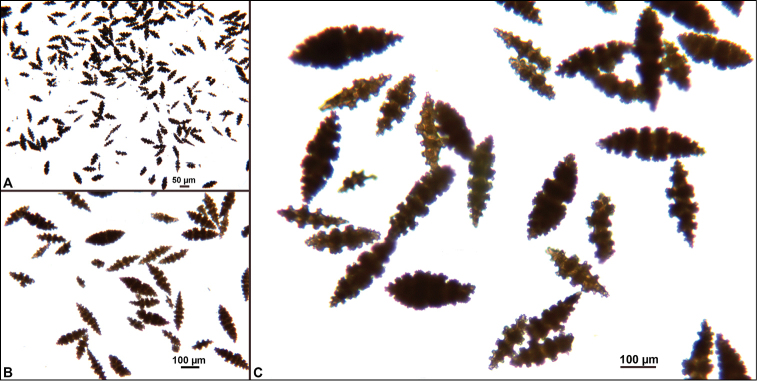
Leptogorgia sp. A, SBMNH 423080, Light microscopy image. All sclerites in SBMNH material are deep yellow in color. A–C Increasing magnifications of coenenchymal sclerites. In some specimens examined, the longest sclerites measured ~280–360 µm, and the smaller, more slender sclerites measured somewhere between 180–260 µm.